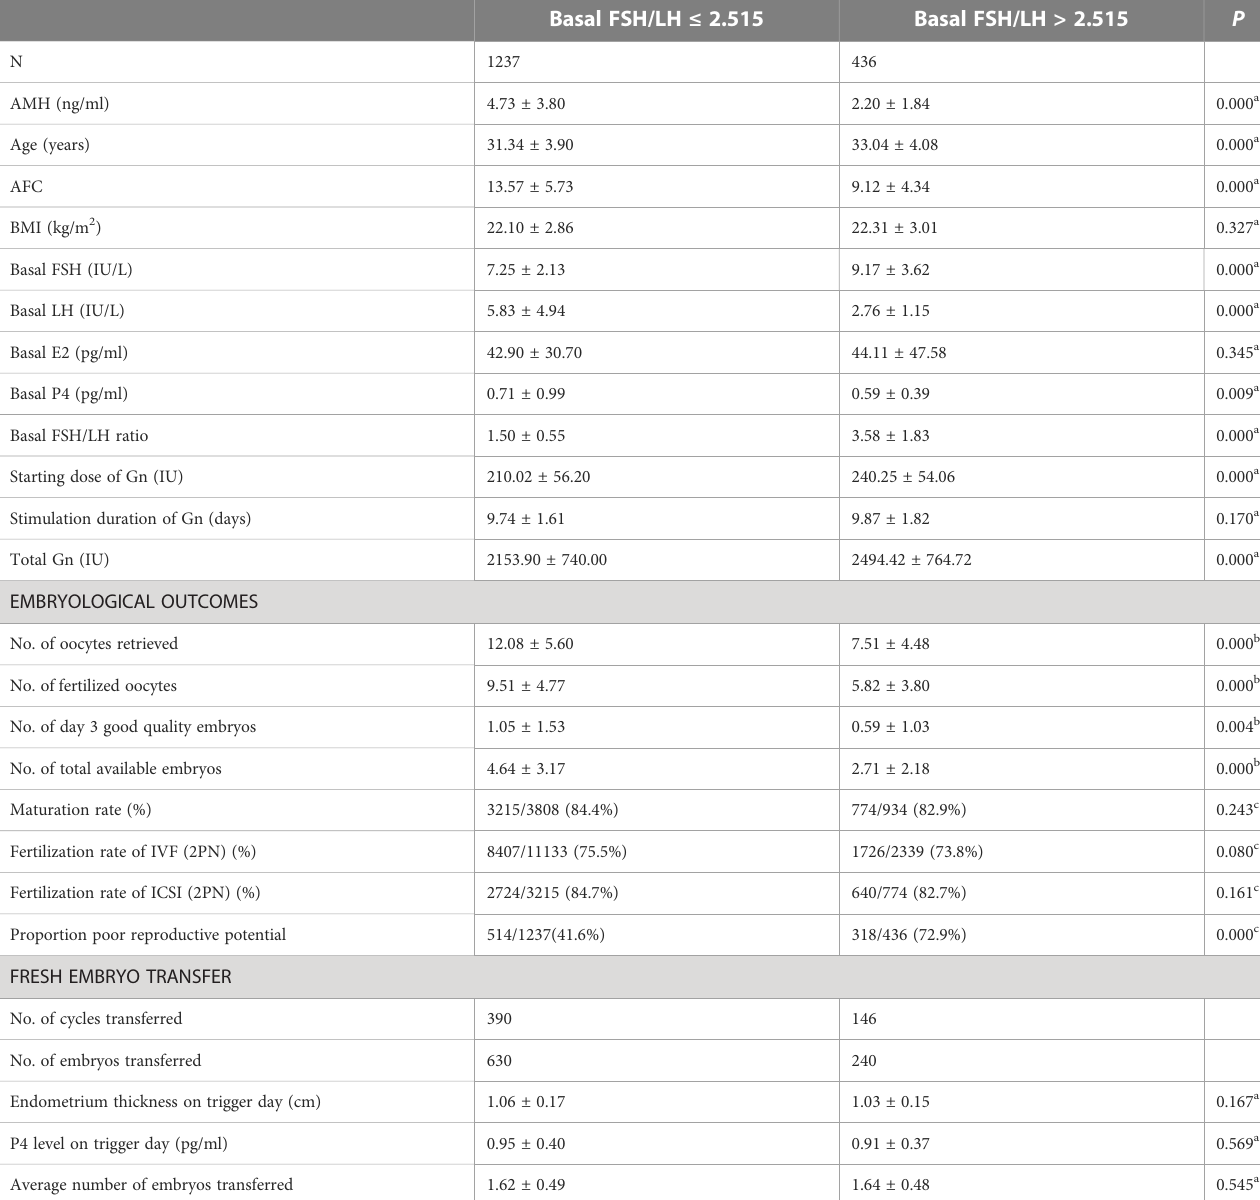
TABLE 3 Basic characteristic, embryological outcomes and clinical outcomes of subgroups based on the basal FSH/LH ratio cutoff value for poor reproductive